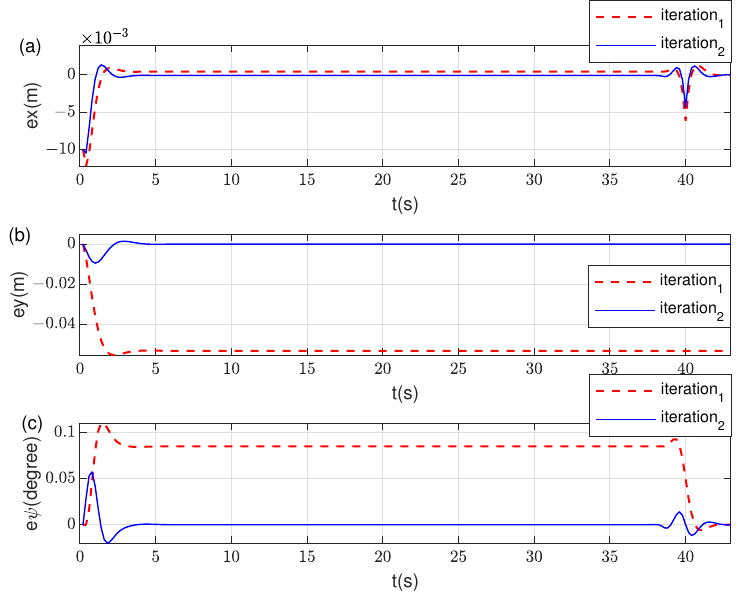
Figure 13. Tracking error under constant wind speed and water flow disturbance: ( a ) longitudinal error; ( b ) lateral error; ( c ) heading angle